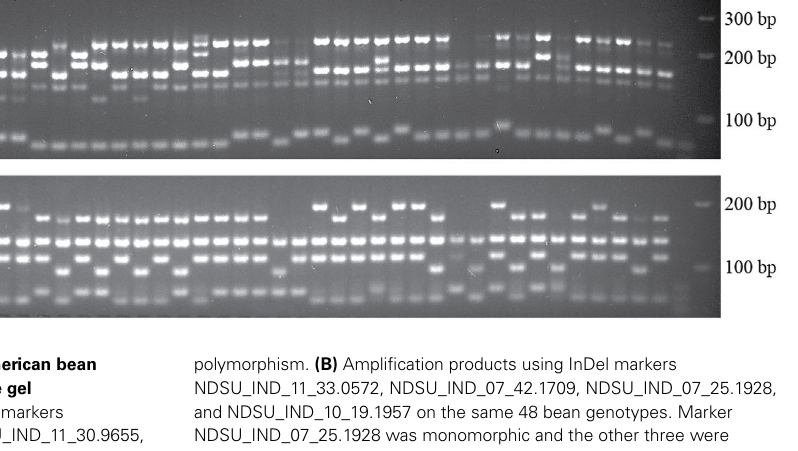
polymorphism. (B) Amplification products using InDel markers NDSU_IND_11_33.0572, NDSU_IND_07_42.1709, NDSU_IND_07_25.1928, and NDSU_IND_10_19.1957 on the same 48 bean genotypes. Marker NDSU_IND_07_25.1928 was monomorphic and the other three were polymorphic. The first lane from the right in (A,B) are the DNA Ladders.